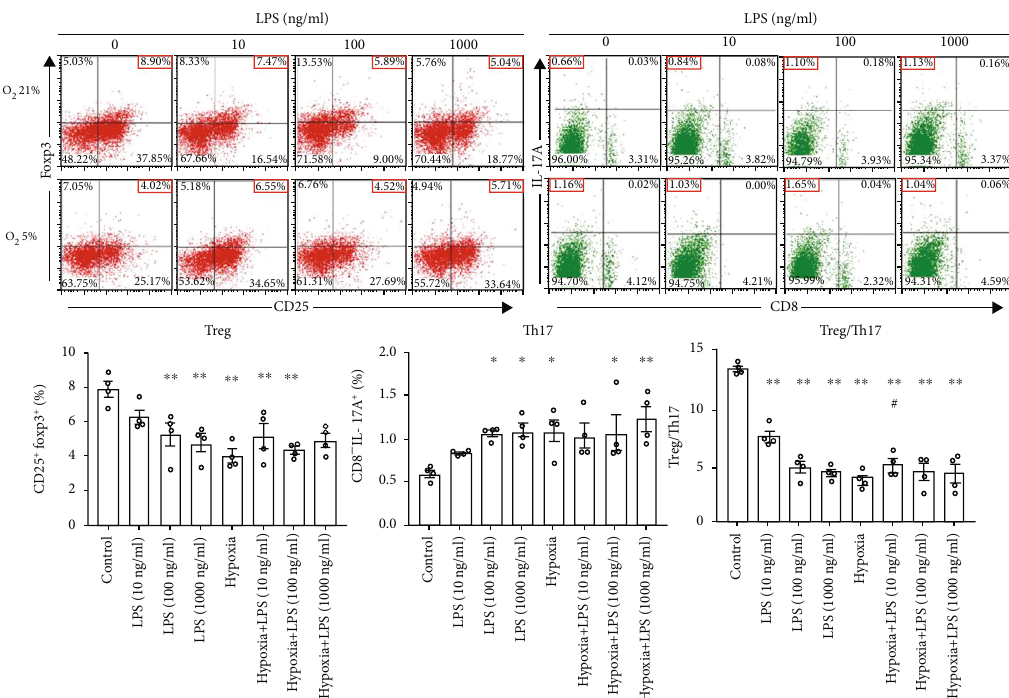
Figure 1: E ff ects of LPS at 10, 100, and 1000ng/ml alone, hypoxia alone, or combined stimulation on mouse splenic CD4 + T cell di ff erentiation to Treg or Th17 population. The phenotype of Treg and Th17 populations after 48-hour stimulation was assessed by fl ow cytometry. Treg cells were identi fi ed by CD25 + Foxp3 + in CD4 + T cells and Th17 cells were by CD8 - IL-17 + in CD4 + T cells. Representative fl ow plots were shown. Bar graphs represent mean frequency ± SEM of Treg and Th17 and mean values ± SEM of Treg/ Th17 ratios in the various groups. ∗ P < 0 : 05 vs. the control group, ∗∗ P < 0 : 01 vs. the control group, and # P < 0 : 05 vs. the LPS (10 ng/ml) group ( n = 4 ). LPS: lipopolysaccharide; SEM: standard error of the mean; Th: T helper; Treg: regulatory T